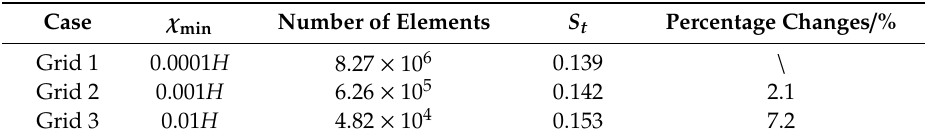
Table 1. Analysis of grid independence.